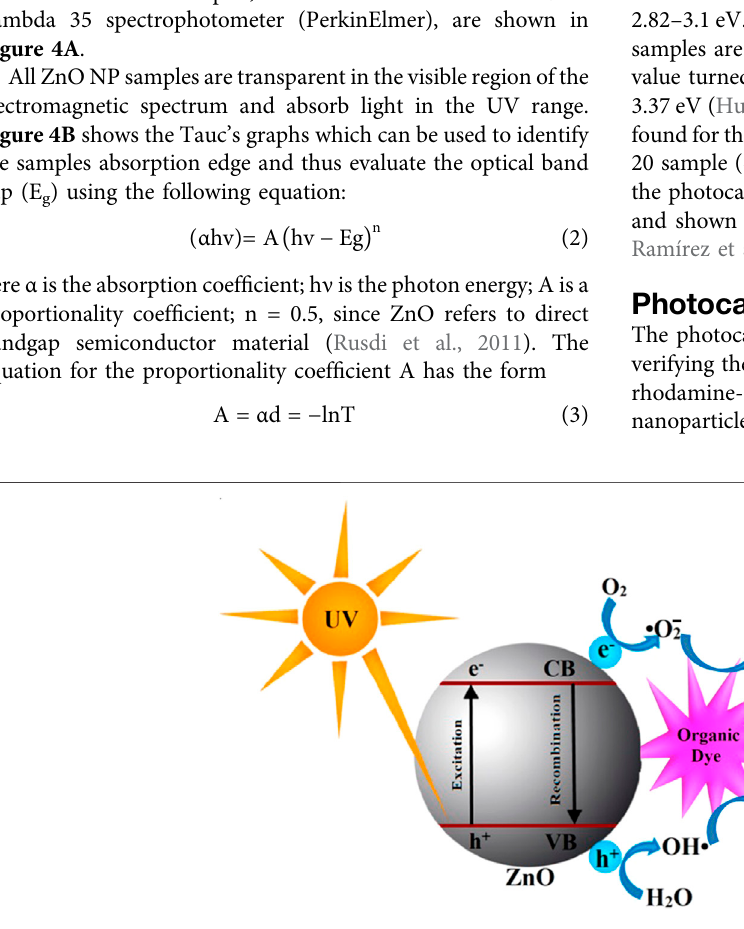
FIGURE 5 | Diagram of the RhB decomposition mechanism on the ZnO NPs